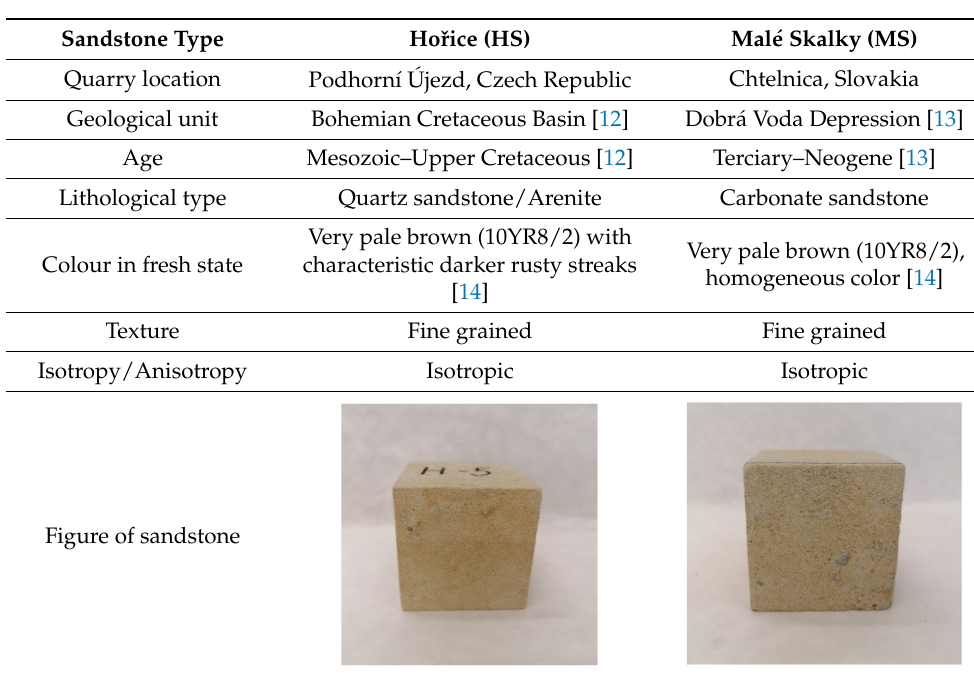
Table 1. Characteristics of the studied sandstones.